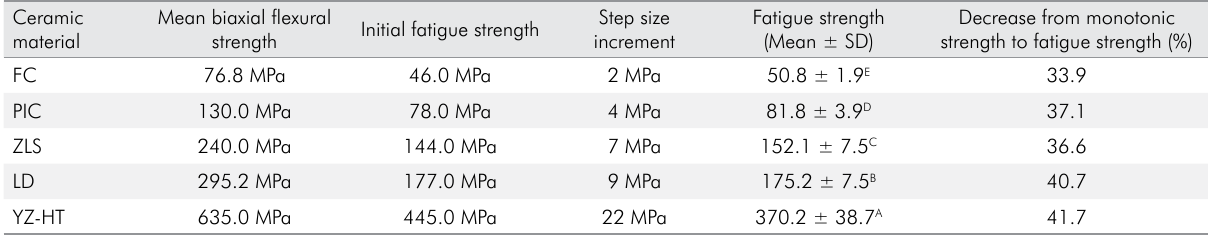
Table 2. Mean biaxial flexural strength (n = 5), initial fatigue strength, step size, fatigue strength data (in MPa) after 100,000 cycles, and the percentage comparison between monotonic and fatigue strength